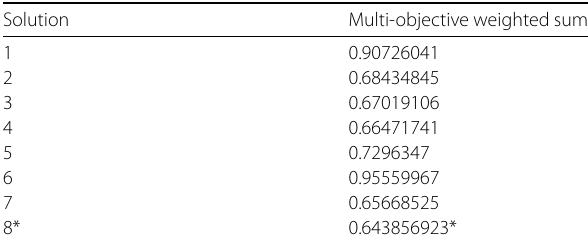
Table 1 Multi-objective weighted sums of Ds f